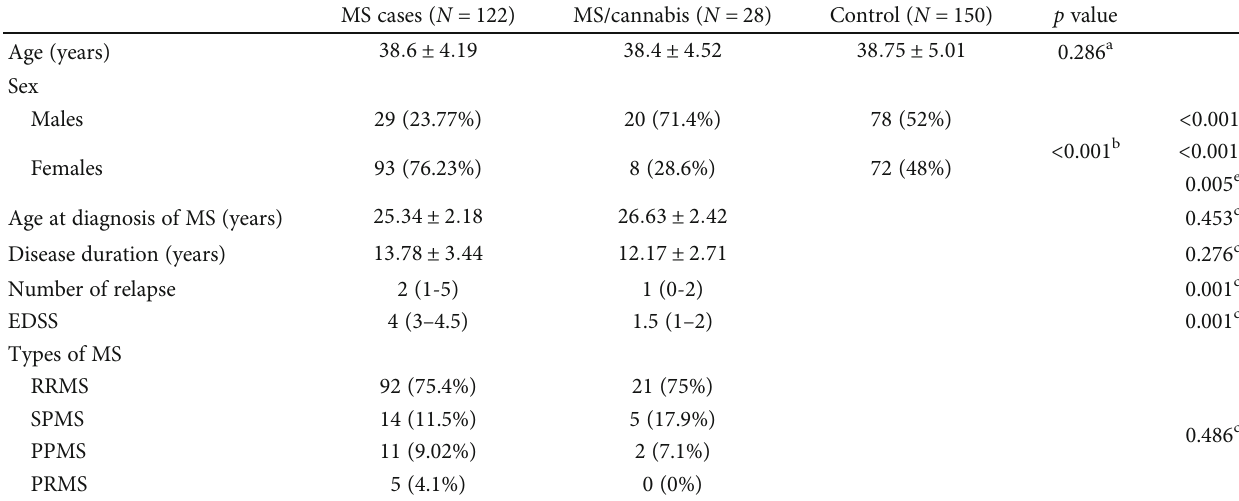
Table 1: Demographic data and clinical criteria in the three study